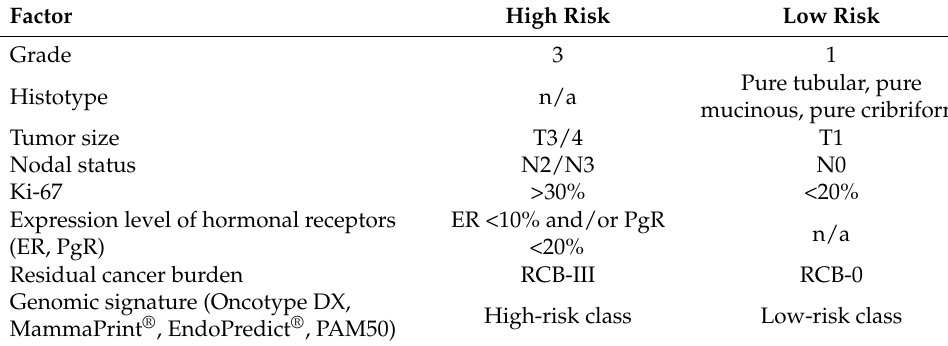
Table 2. Synoptic table of risk factors for disease